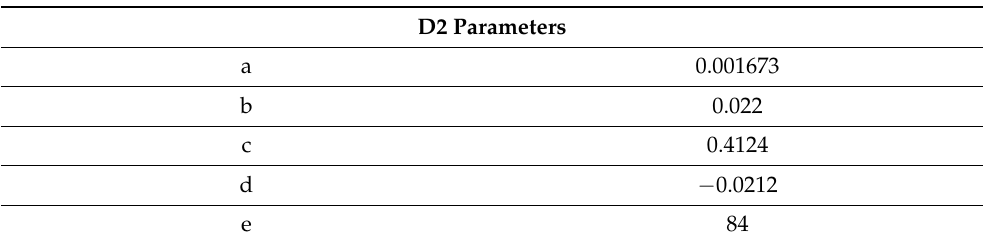
Table 2. D2 degradation model